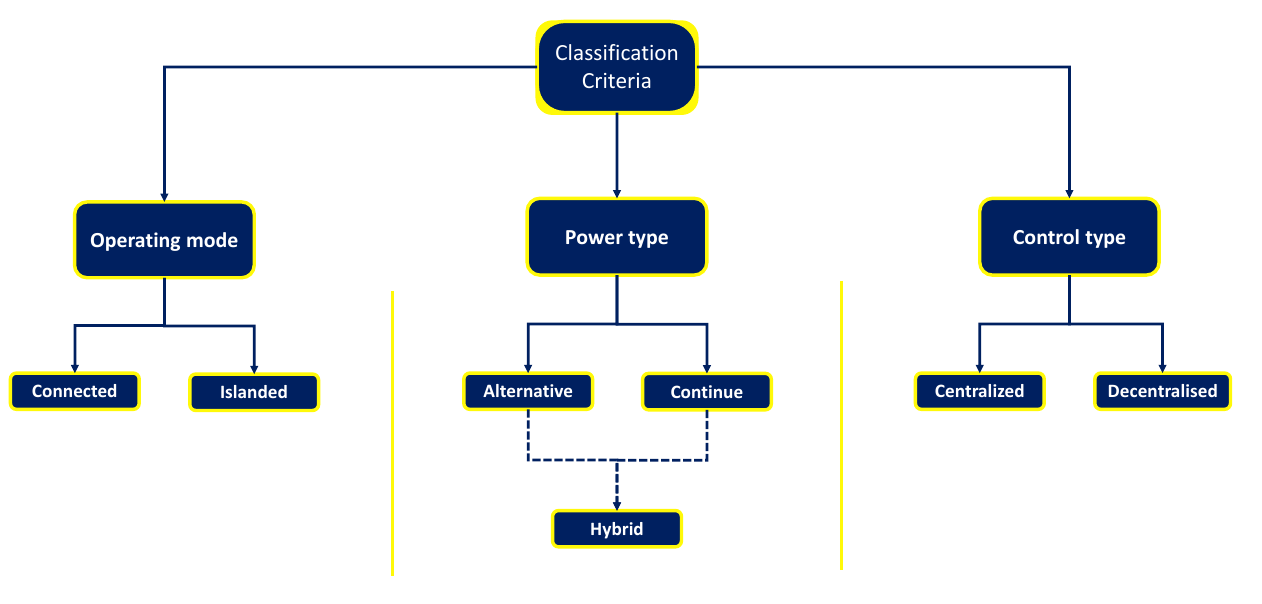
Figure 7. Microgrids